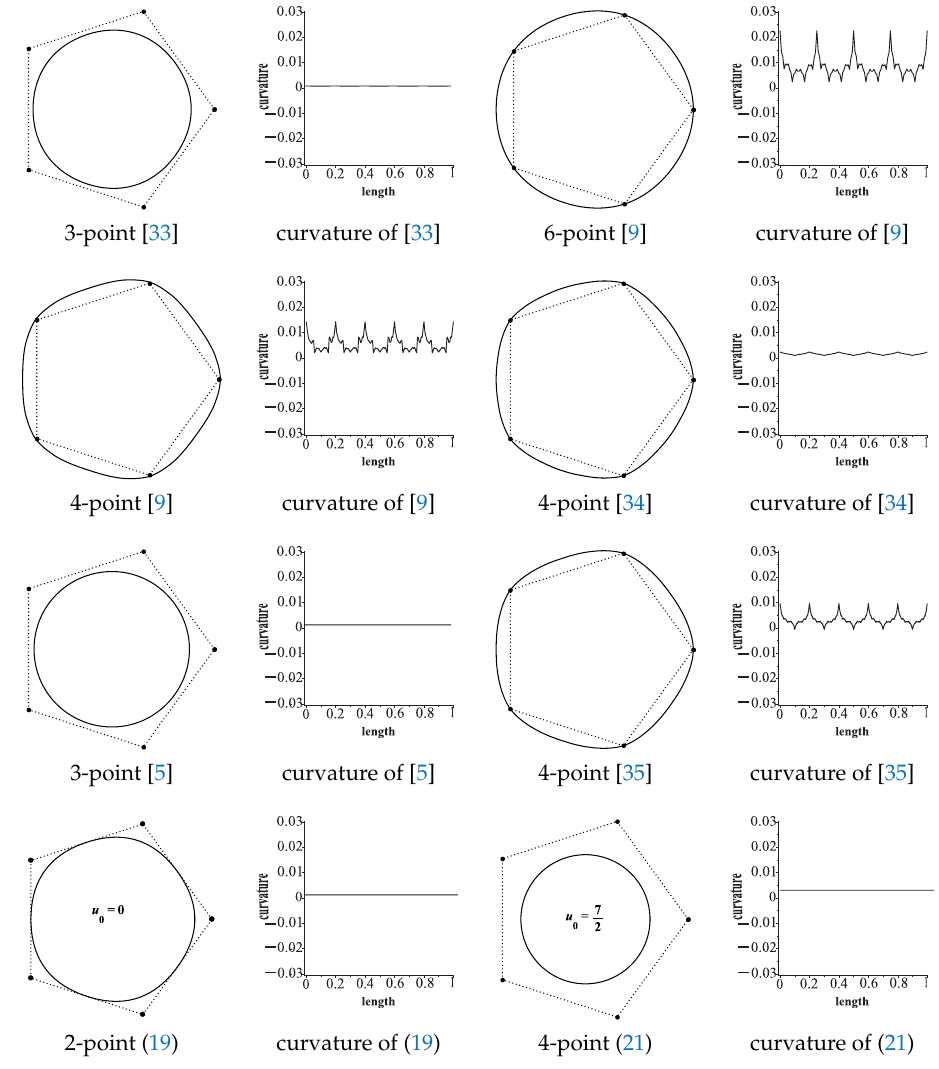
Figure 3. Comparison of existing and our proposed SS when five control points are sampled from circle. Limit curves obtained after 5th iteration are shown in the left column, the corresponding curvatures are shown in the right